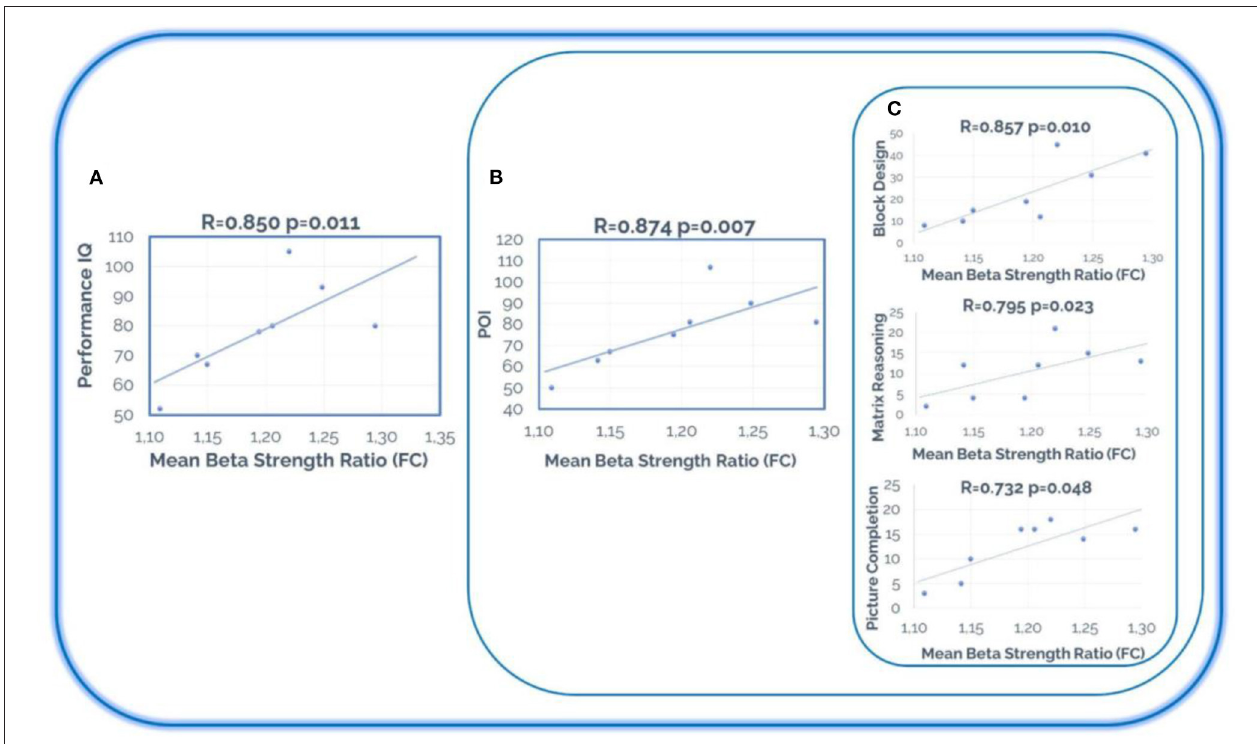
FIGURE 6 | Recovery prediction. Statistically significant differences between the cognitive scores in the pre-condition and the mean beta strength ratio (post/pre) in the stroke patients’ group. (A) Performance IQ (WAIS-III); (B) POI (Perceptual Organization Index of WAIS-III); (C) Block Design, Matrix Reasoning, and Picture Completion (of WAIS-III). Note that the tests represented in this figure are related to each other, since Block Design, Matrix Reasoning, and Picture Completion are the tests included in Perceptual Organization Index, and POI (Perceptual Organization Index) is included in Performance IQ (on the WAIS-III